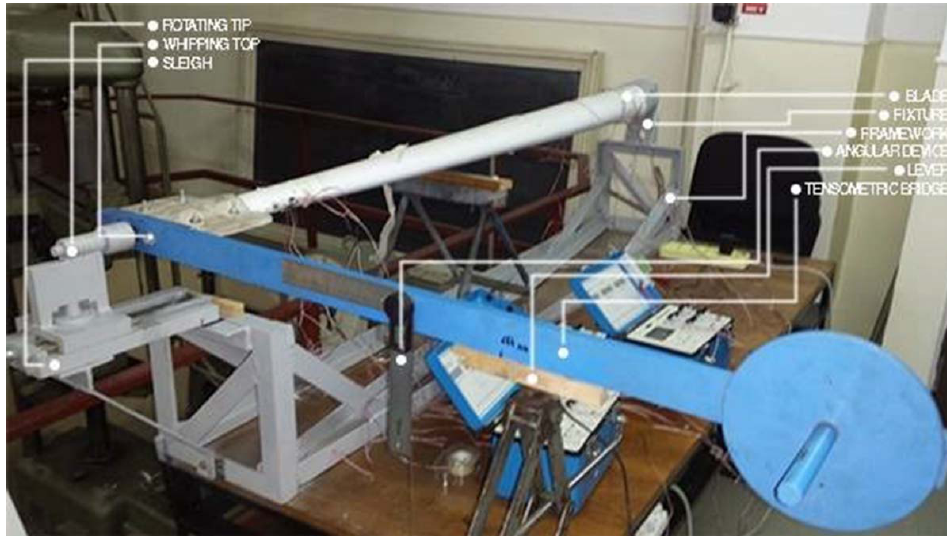
Figure 4. Torsion device with mounted blade model.